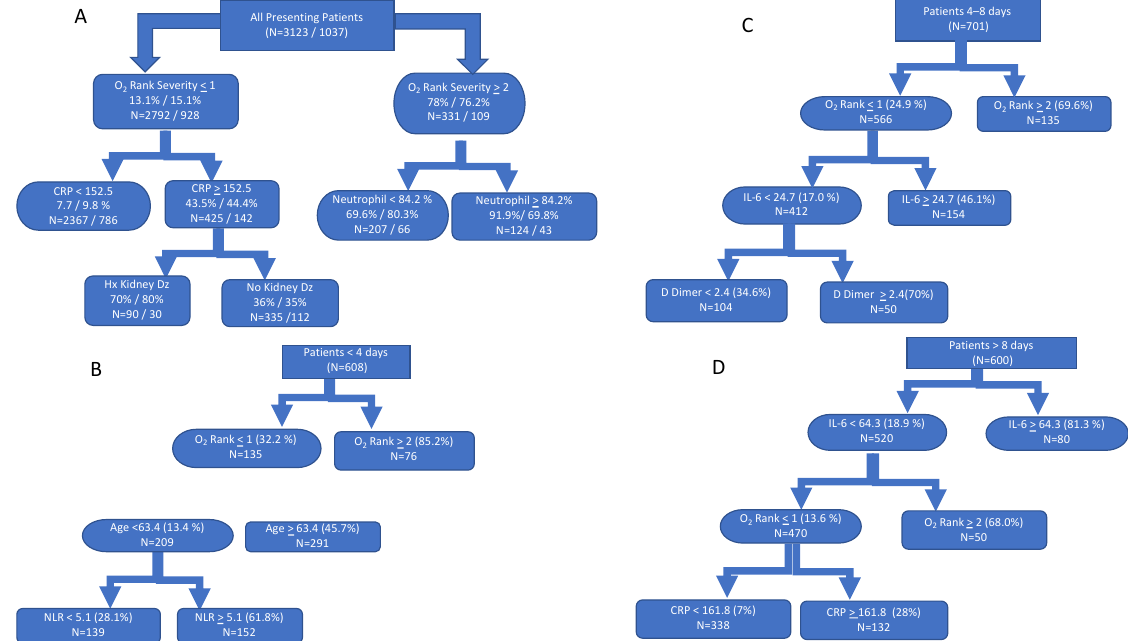
Figure 2. Classification and regression trees assessing predictors of poor outcome. Pruned classification trees that identified, ranked, and defined threshold cut points for predictors of decompensation in ( A ) all patients with COVID-19 presenting to the emergency department: first % represent prediction and second % represent validation; and in patients with a recorded date of symptom onset within ( B ) ≤ 4 days (tertile 1), ( C ) 4–8 days (tertile 2), and ( D ) >8 days (tertile 3) of hospital presentation. Decompensation was defined as a composite outcome of intubation, death, or discharge to hospice. Abbreviations and definitions: CRP, C-reactive protein; IL-6, interleukin-6; LDH, lactate dehydrogenase; NLR, neutrophil to lymphocyte ratio; OSR ≤ 1, nasal cannula; OSR ≥ 2, non-rebreather, non-invasive ventilation. Table 2. Multivariable logistic regression model of predictive variables identified through classification tree analysis.